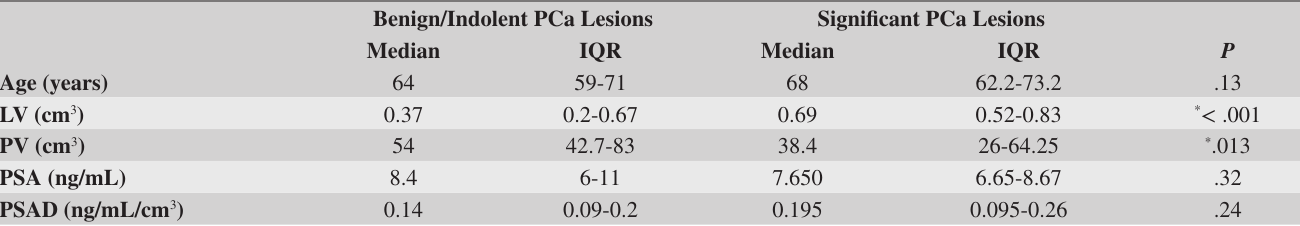
Table 3. Variables under Investigation in the Groups of Benign/Indolent and Significant PCa Lesions